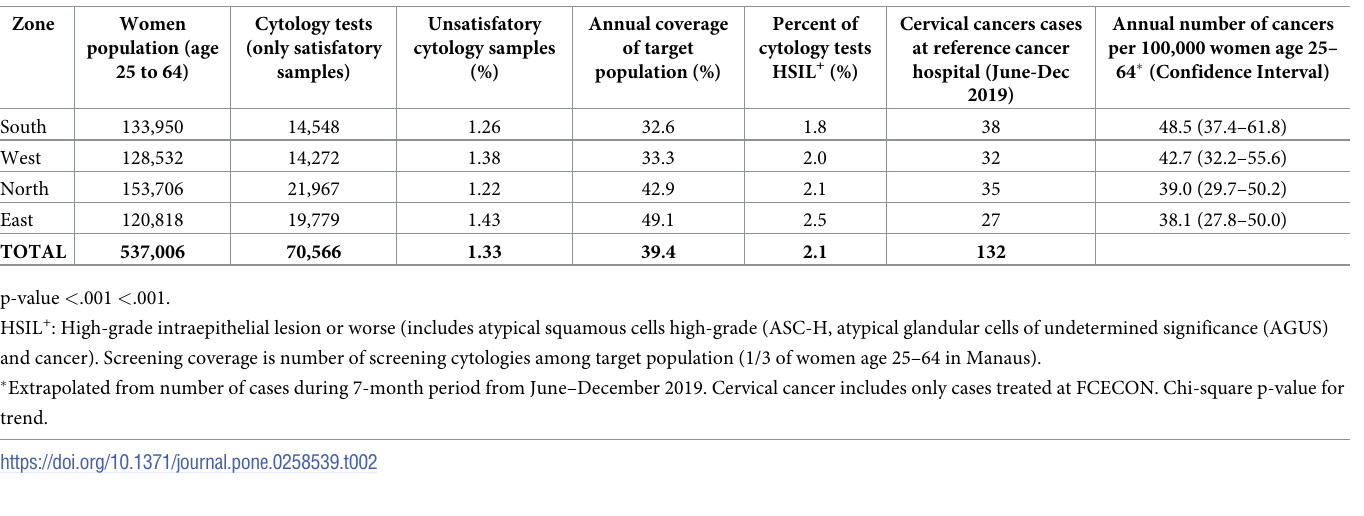
was inversely correlated with screening coverage (mean 55.7%, range: 0–240%, median 44.0%) (Pearson’s r = -0.39, p = .005).